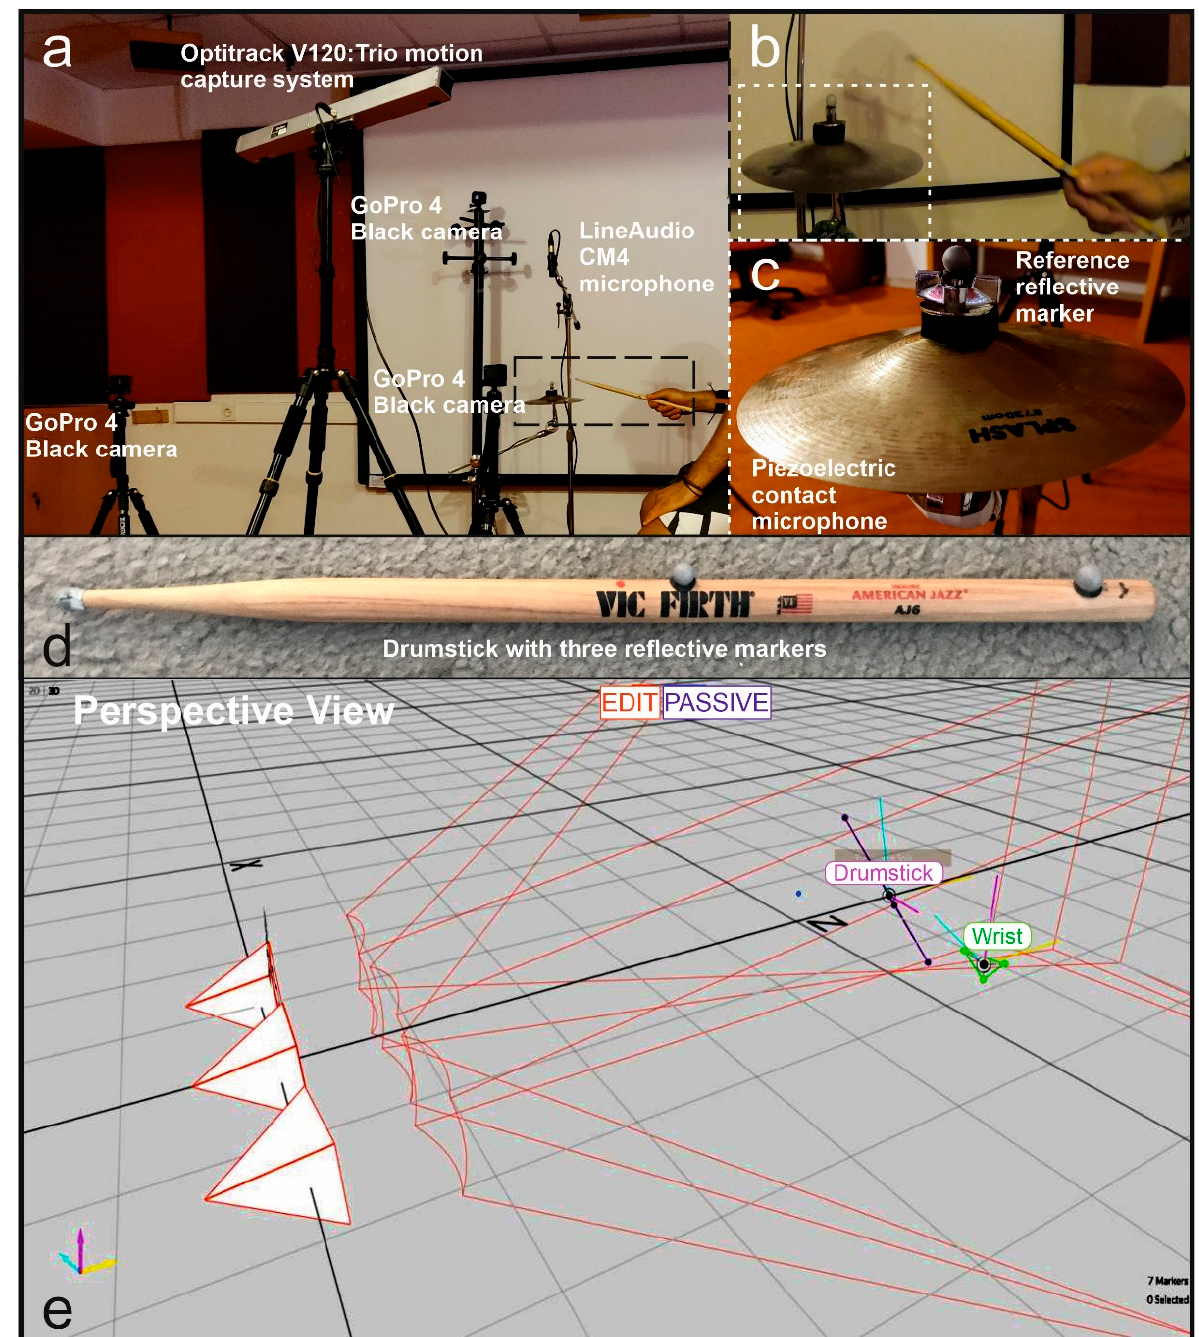
Figure 2. ( a ) Experimental setup demonstrating the Optitrack V120:Trio motion capture system, three reference cameras, the LineAudio CM4 microphone, the cymbal, and the drummer, ( b ) zoomed detail of ( a ) in the cymbal–drummer positioning, ( c ) zoomed detail of ( b ) in the cymbal, the reference marker, and the piezoelectric contact microphone, ( d ) drumstick with the three reflective markers attached, ( e ) coordinate system origin attached to Optitrack V120: Trio system.